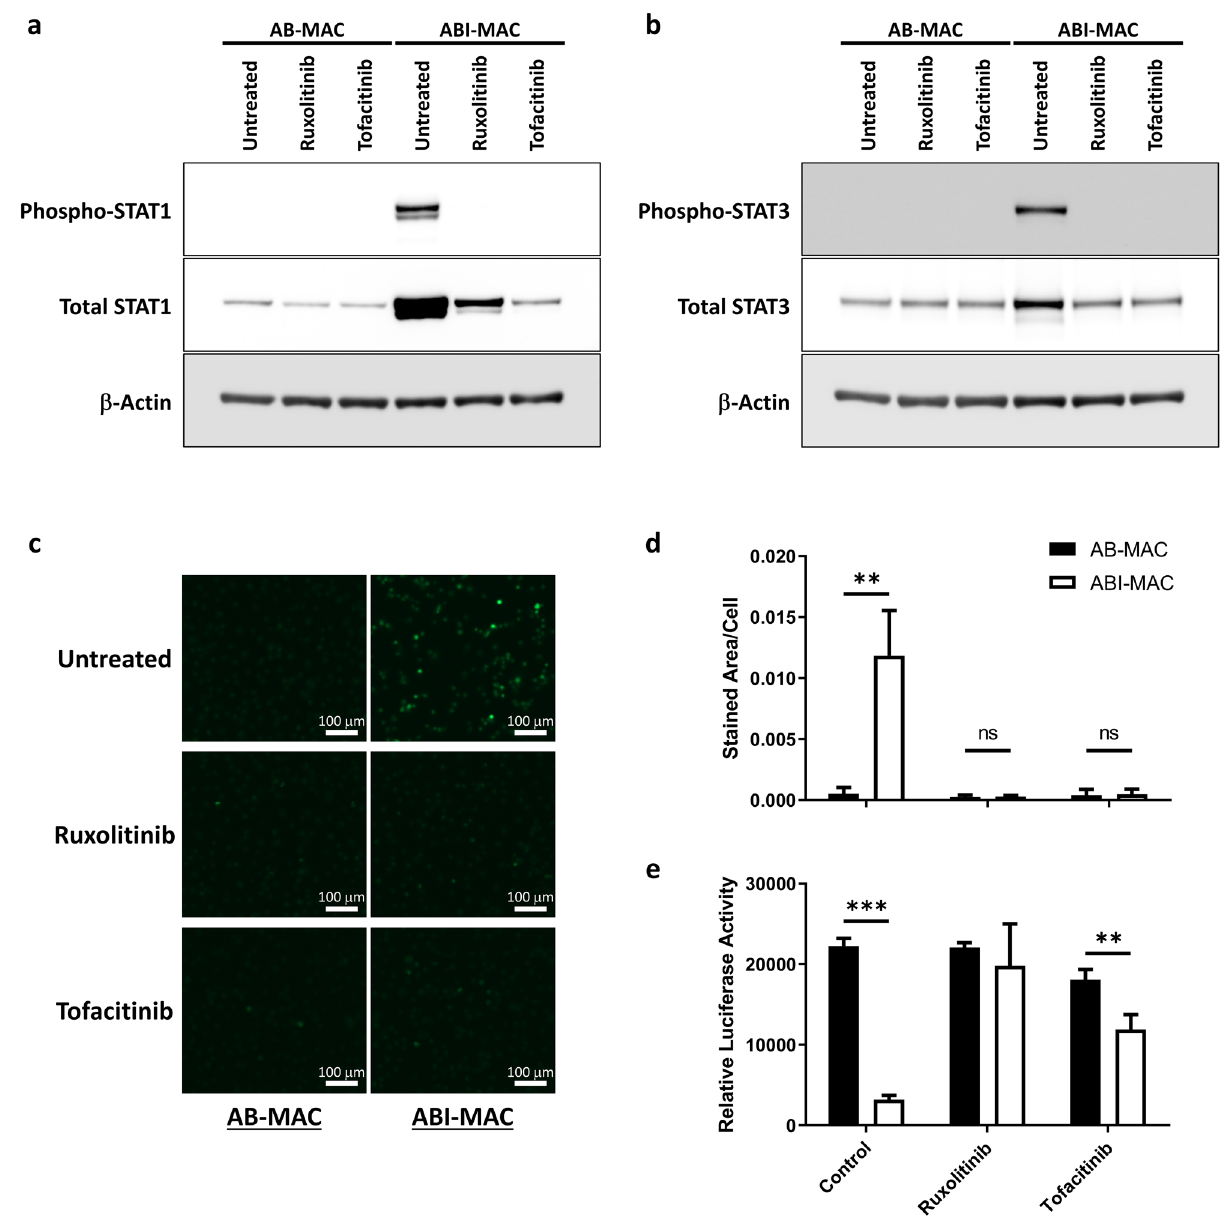
Figure 5. Impact of JAK inhibitors on autophagy induction and HIV inhibition. Monocytes were differentiated into AB-MAC and ABI-MAC either as described before or treated with Ruxolitinib or Tofacitinib. After differentiation, a first subset of cells was immediately lysed in RIPA buffer, proteins were run on 4–12% Bis– Tris gels in MOPS buffer then transferred onto 0.45 μm nitrocellulose membranes. Blots were probed for ( a ) phospho-STAT1, total STAT1 and β-Actin or ( b ) phospho-STAT3, total STAT3 and β-Actin as described in the “Materials and methods”. Results indicate representative blots from a single donor, original blot images are displayed in Supplementary Figs. S13 and S14. ( c ) Autophagosome staining was performed using the Cyto-ID reagent on a second subset of cells, and ( d ) images were quantified as described in the “Materials and methods”; displayed values represent mean and SD, and relevant Student’s t -test are indicated, **p < 0.01 (n = 4). ( e ) A third subset of cells was infected with HIVLuc-V and HIV infection assay was performed as described in the “Materials and methods”. Displayed values are mean relative luciferase activities from three independent donors; error bars denote standard deviations. Results of significant and relevant Student’s t -tests are indicated, **p < 0.01, and ***p <